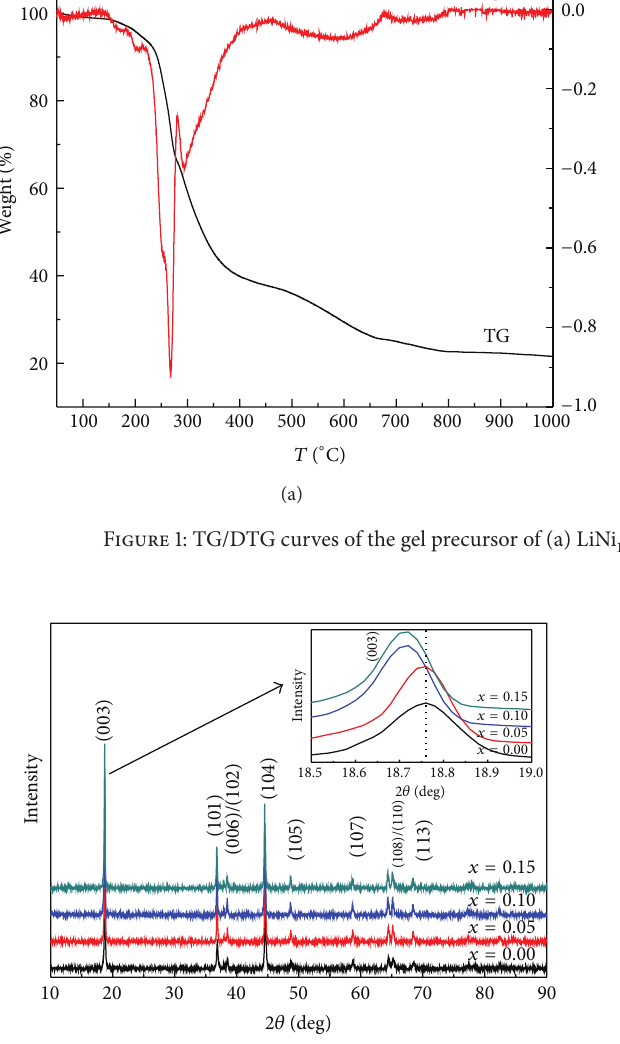
Figure 2: XRD patterns of LiNi 1/3 Co 1/3 Mn 1/3 O 2−𝑥 Cl 𝑥 cathode materials.